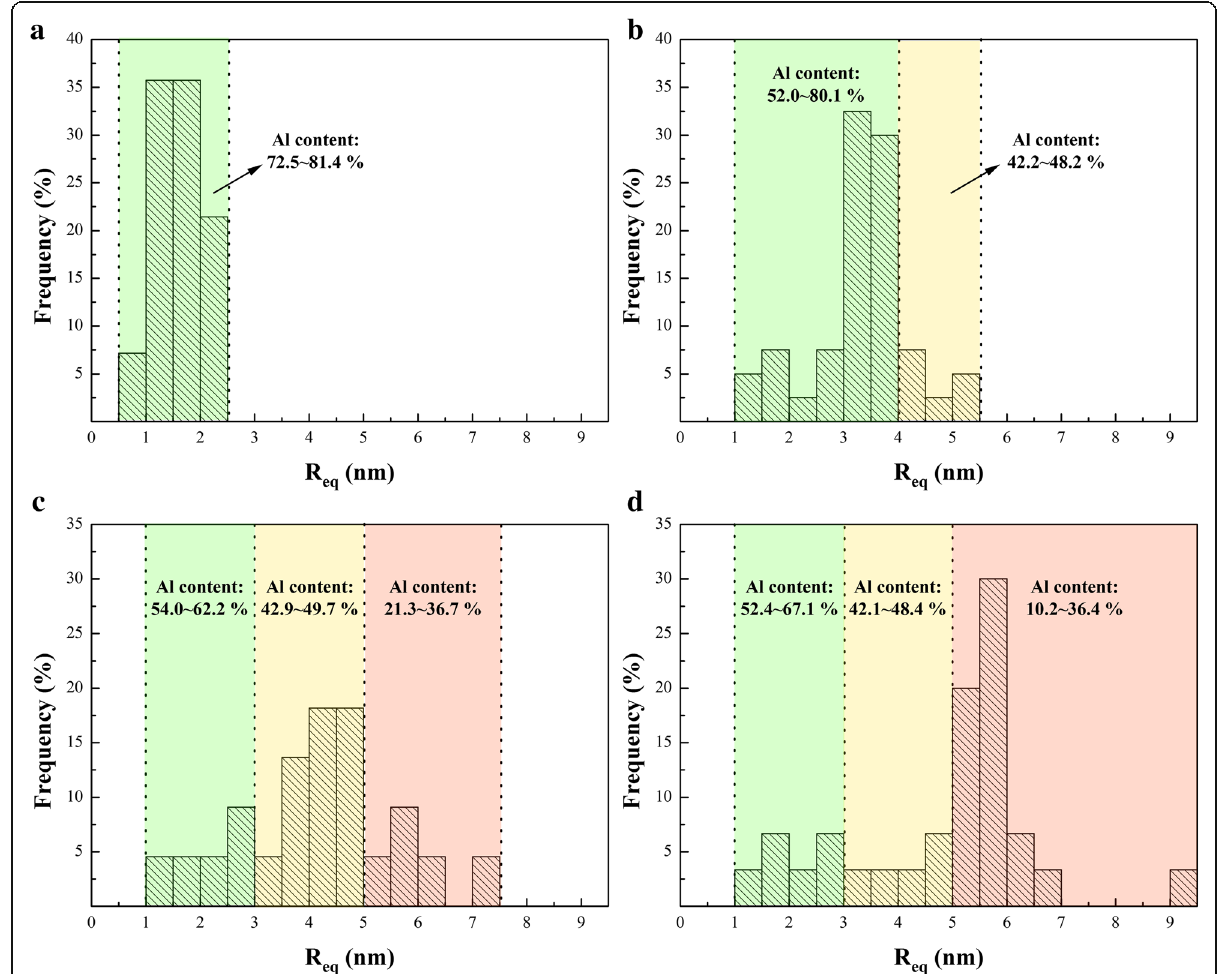
Fig. 4 Distribution of equivalent radius ( R eq ) and the corresponding Al content (in at. %) of the nanoparticles in different second-stage aging states: a UA, b PAI, c PAII, and d